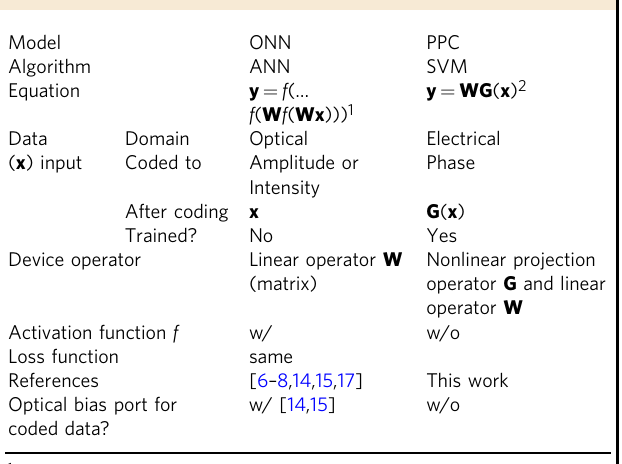
Table 1 Model comparison between ONN and PPC in this